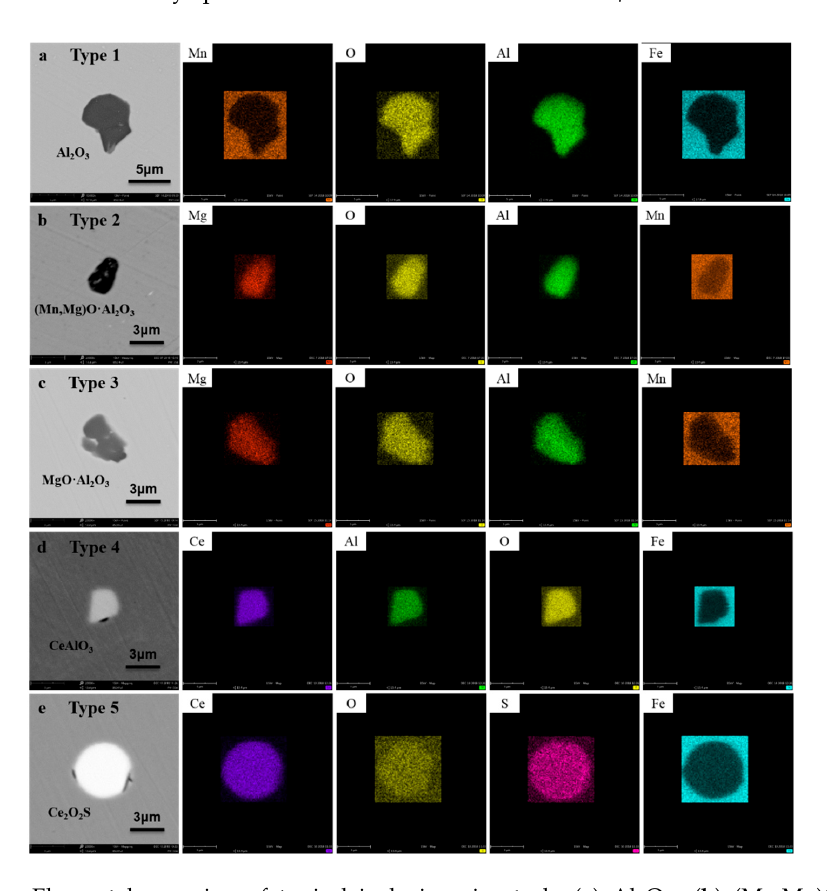
Table 2. Chemical composition of experimental steels (mass fraction/%).